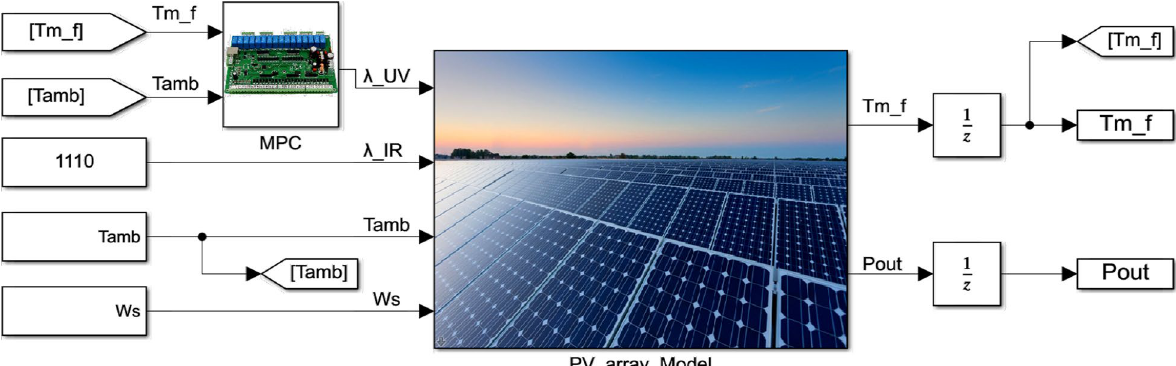
Fig. 6 Simulation diagram of MPC controller of PV modules in Simulink